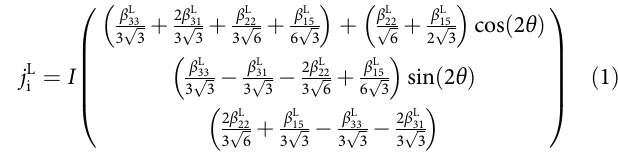
wherein I is the light intensity, β L are the LBPV coef fi cients, ij and θ is the angle describing the rotation of the electric fi eld plane of the LP light around the z-axis. The rotation is achieved by Þ plate. using a half-wave ð λ 2